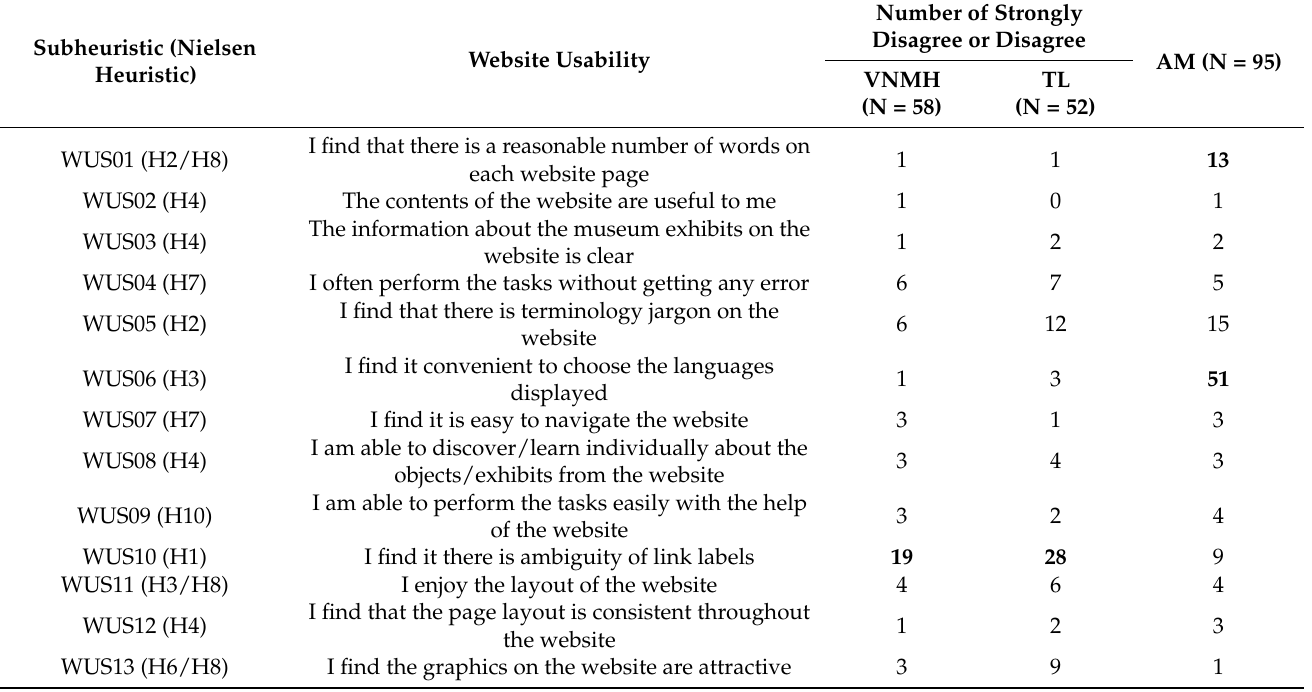
Table 5. Usability evaluation of websites (bold values represent the highest number of Strongly Disagree or Disagree in each